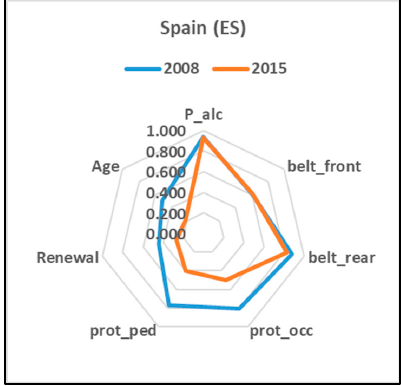
Figure 7. The normalized SPI values for Spain over time. Appl. Sci. 2022 , 12 , x FOR PEER REVIEW